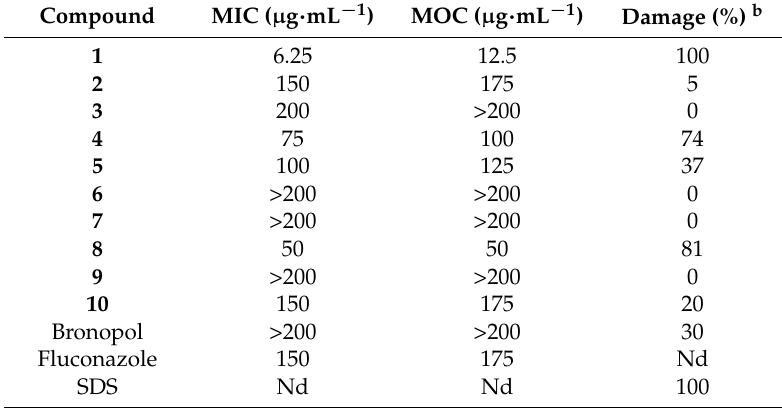
Table 1. In vitro anti-oomycete activities values a of synthesized compounds against S. australis . Compound MIC ( µ g · mL − 1